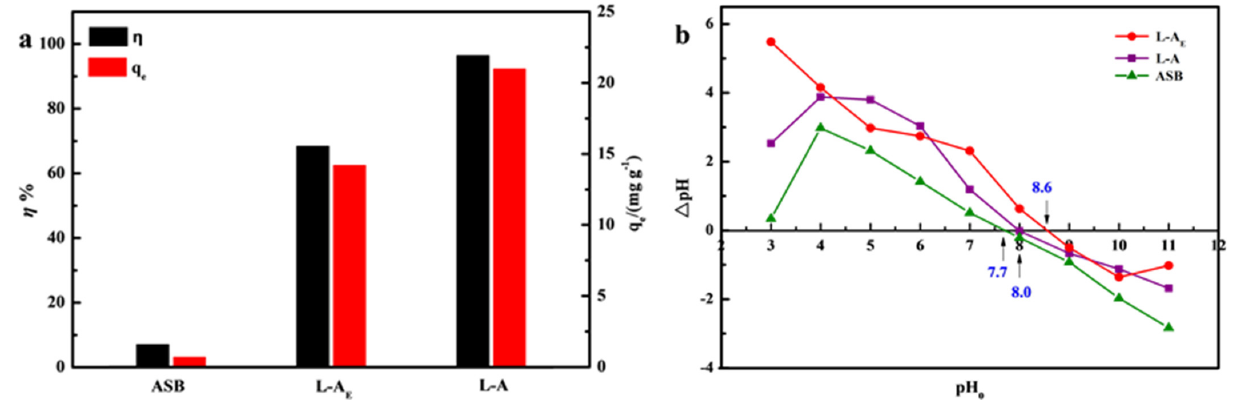
Figure 1. Comparison of ( a ) adsorption performance and ( b ) zero−point charge pH of the materials.